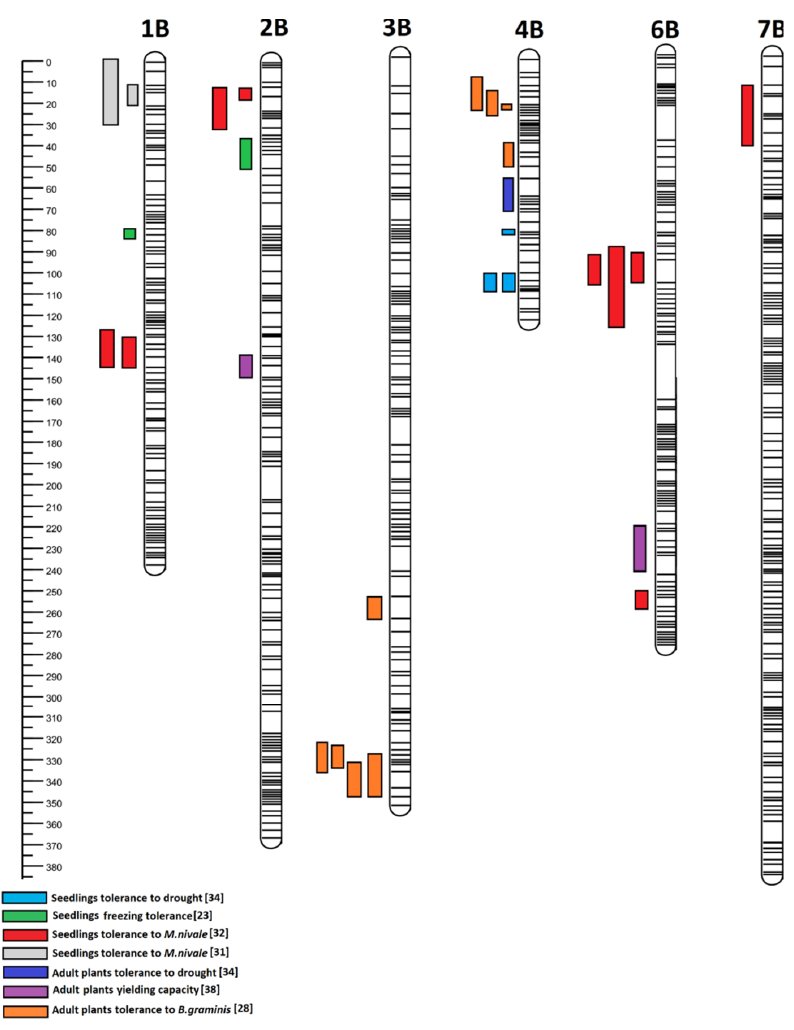
Figure 2. Subgenome B regions identified for the winter triticale DH ‘Hewo’ × ‘Magnat’ mapping population, related to seedling tolerance to drought, freezing and pink snow mold caused by M. nivale , as well as adult plants tolerance to drought, powdery mildew and yielding capacity in the generative phase. Subgenome regions were determined by bioinformatics using the genetic map published by Tyrka et al. [21] and Windows QTL Cartographer V2.5_011.